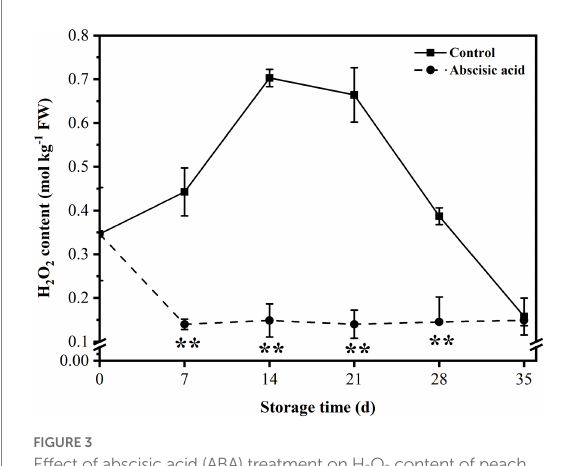
FIGURE 3 Effect of abscisic acid (ABA) treatment on H 2 O 2 content of peach fruit during cold storage at 4 ° C. Vertical bars represent the standard deviation of the means of triplicate samples ( n = 3). The symbol ( ** ) indicates significant differences among different treatments at p <